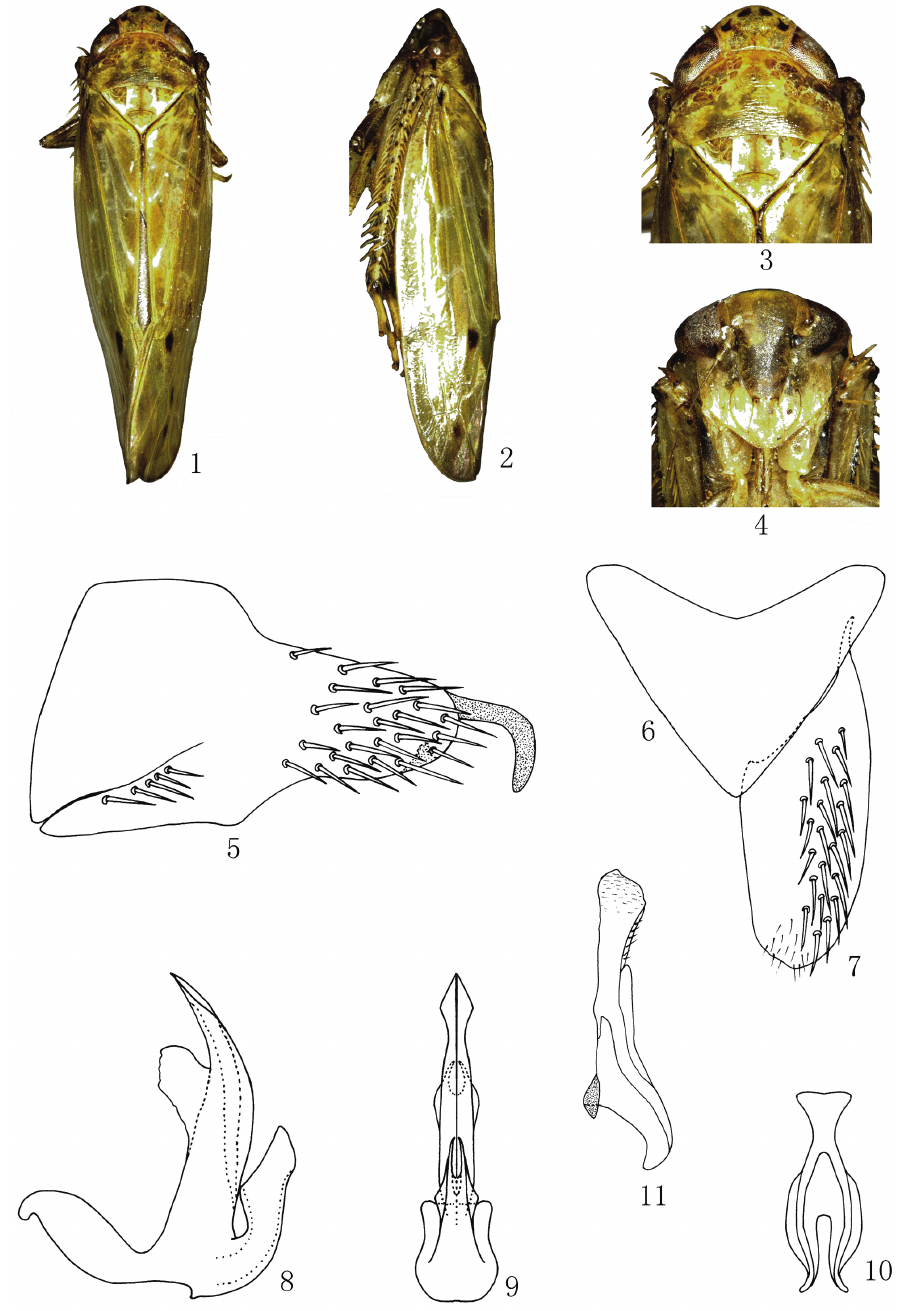
Figures 1–11. Abrus damingshanensis sp. n., 1 ♂ , dorsal view 2 ♂ , lateral view 3 ♂ , head and thorax, dorsal view 4 ♂ , face 5 Male pygofer side, lateral view 6 Valve, ventral view 7 Subgenital plate, ventral view 8 Aedeagus, lateral view 9 Aedeagus, caudal view 10 Connective, ventral view 11 Style, dorsal